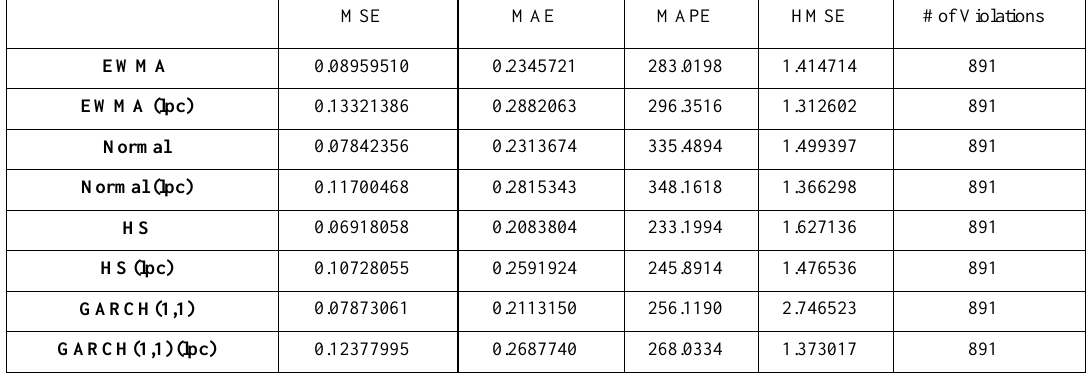
Table 3. Evaluation measures results for PVaR with and without lpc of NBG warrants – 1